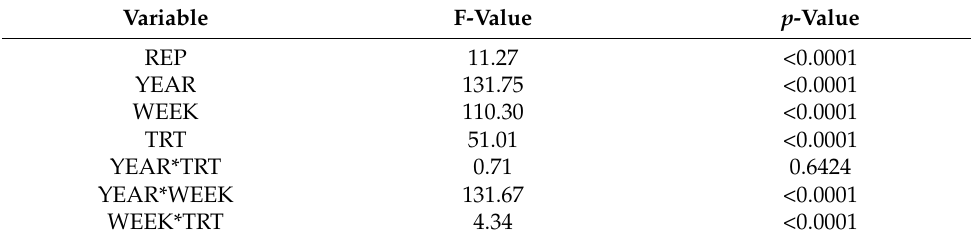
Table 7. Analysis of variance for the soil